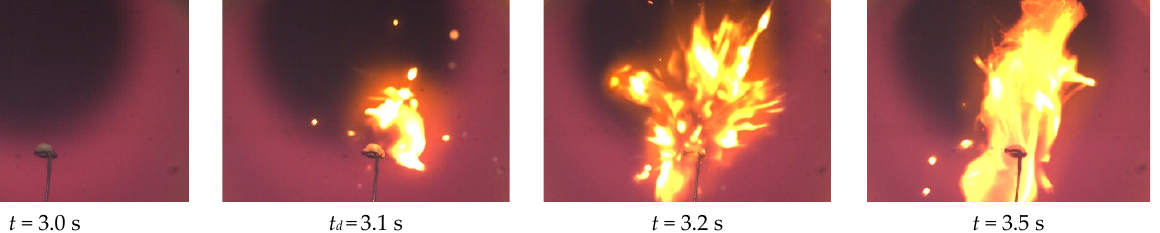
Figure 17. Typical videoframes of ignition and combustion of a particle of gel fuel (composition No. 1—without solid particles: 50 vol% oil + 48 vol% aqueous solution of PVA + 2 vol% emulsifier) at T g = 900 °C [186].